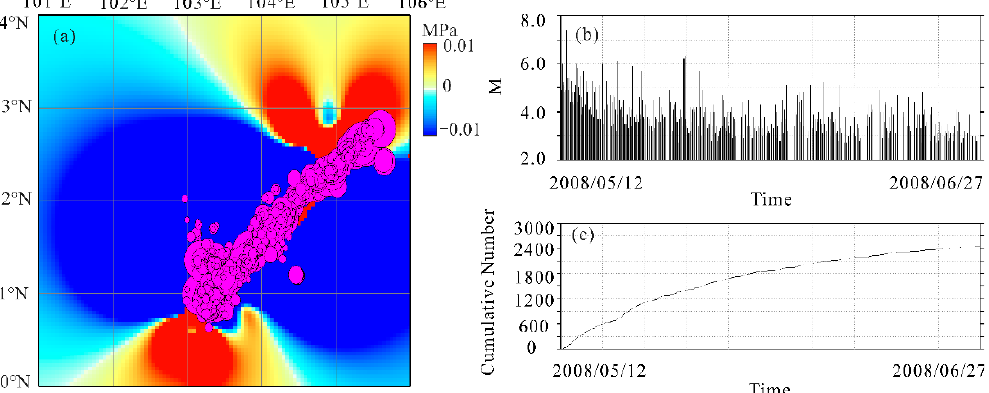
Figure 3. ( a ) Distribution of coseismic Coulomb failure stress changes caused by the 2008 Ms 8.0 Wenchuan earthquake at the depth of the mainshock and aftershocks (Zhu et al. [72]). ( b ) Temporal distribution of the aftershock magnitudes. ( c ) Cumulative number of aftershocks over time.